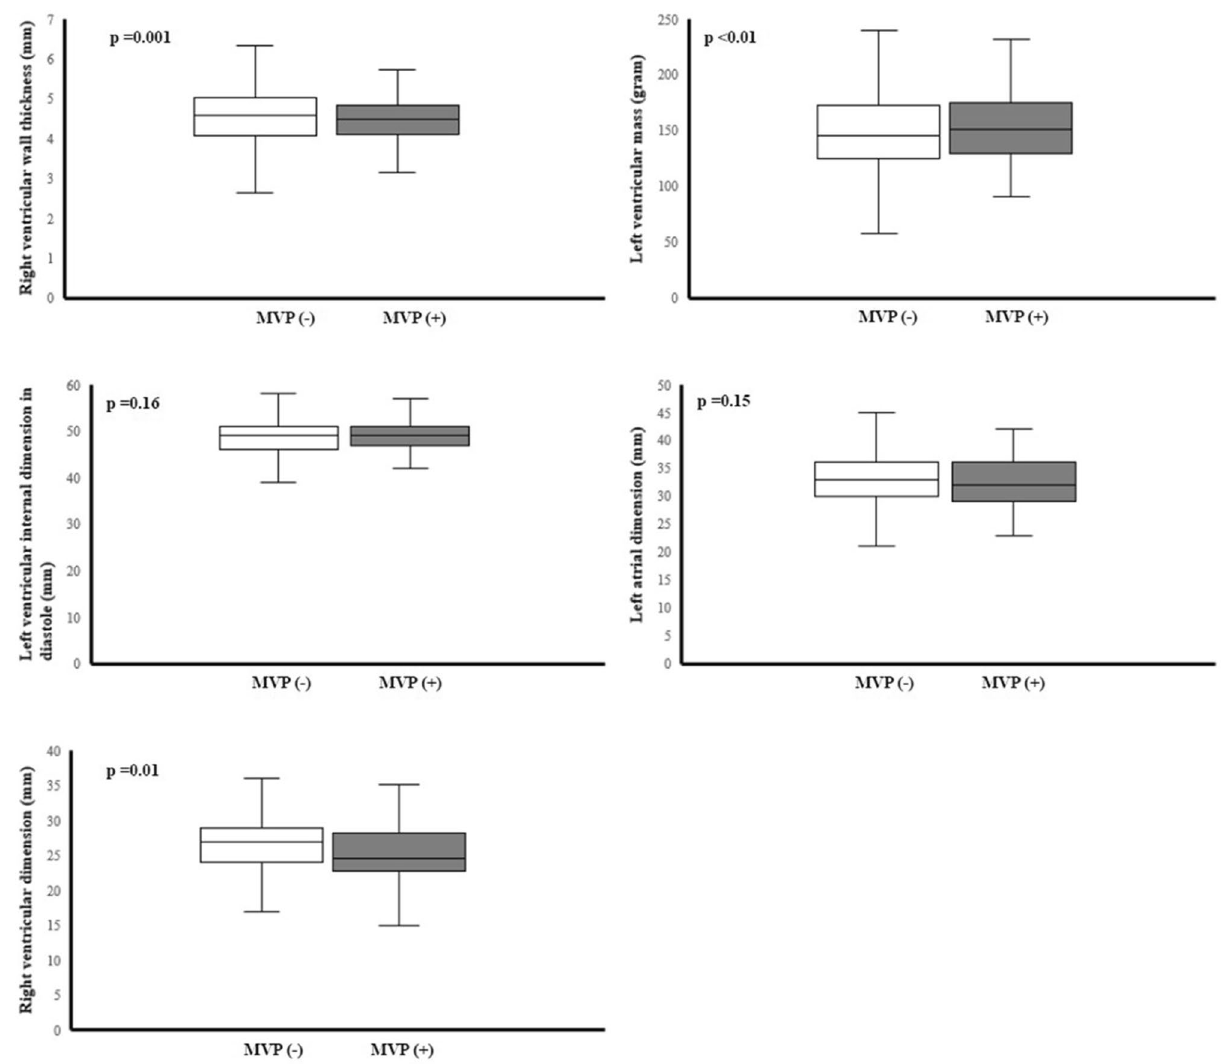
Figure 1. Echocardiographic left atrial dimension, left ventricular internal dimension in diastole, left ventricular mass, right ventricular outflow tract dimension in diastole and right ventricular wall thickness in the overall population were compared using analysis of covariance with adjustment for body surface